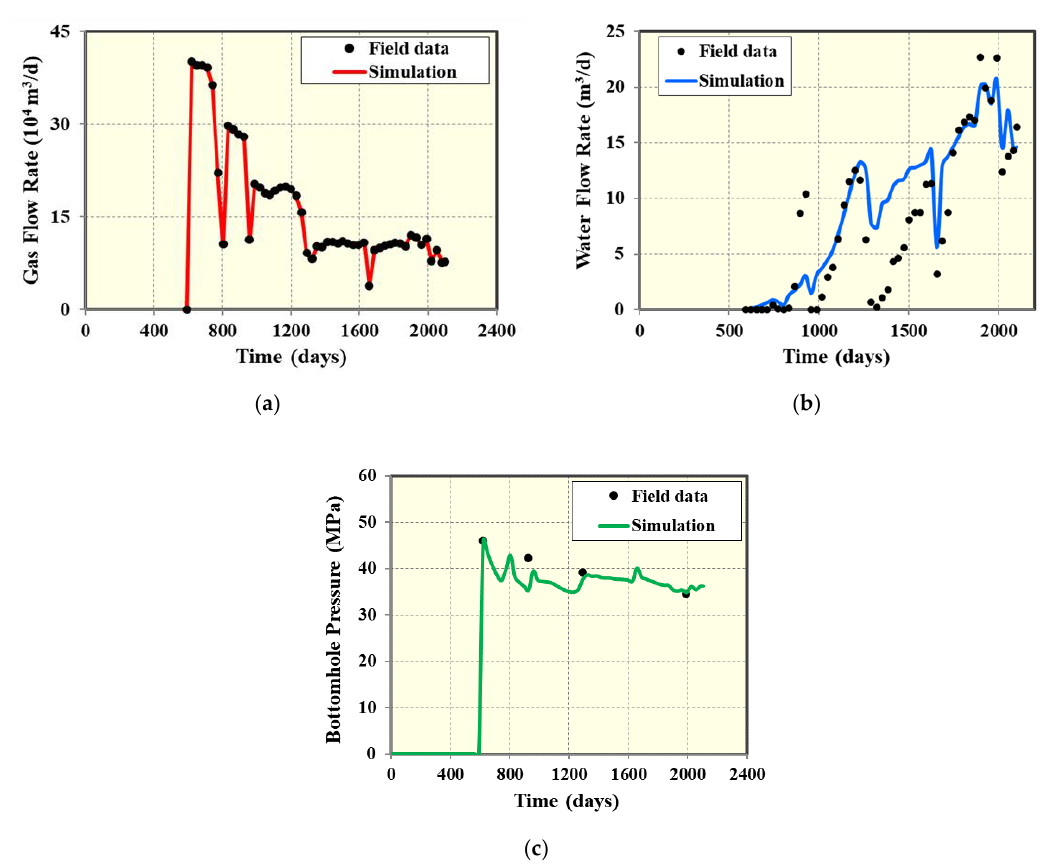
Figure 25. Single-well model simulation and history matching results of well B3. The points represent the field data while the solid lines represent the simulated values: ( a ) gas flow rate history matching results; ( b ) water flow rate history matching results; ( c ) bottom-hole pressure (BHP) history matching results.